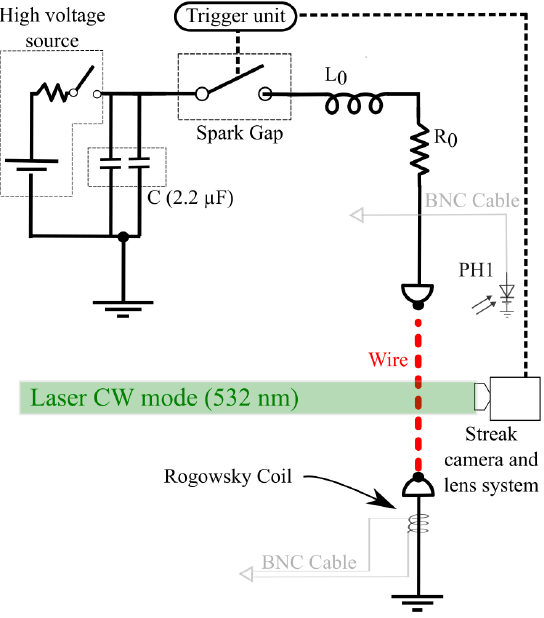
Figure 1. (Color online) experimental setup. PH1 signals the photodiode, C the capacitors bank, L 0 the lumped inductance, 142 nHr, and R 0 the resistance; both of the whole setup circuit.